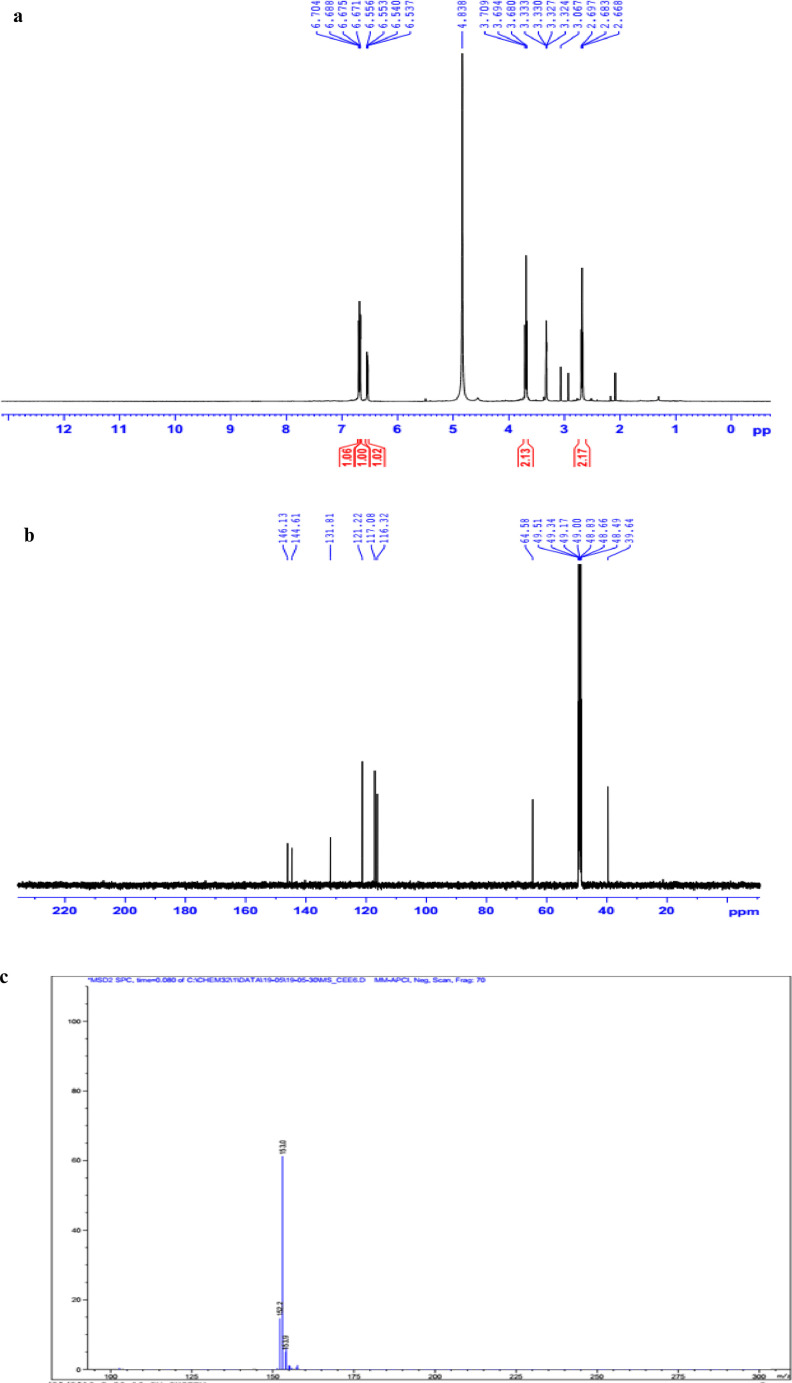
a. 1H NMR (500 MHz, CD3OD) of 6, b. 13C NMR (125 MHz, CD3OD) of 6, c. (-) APCI-MS of 6.